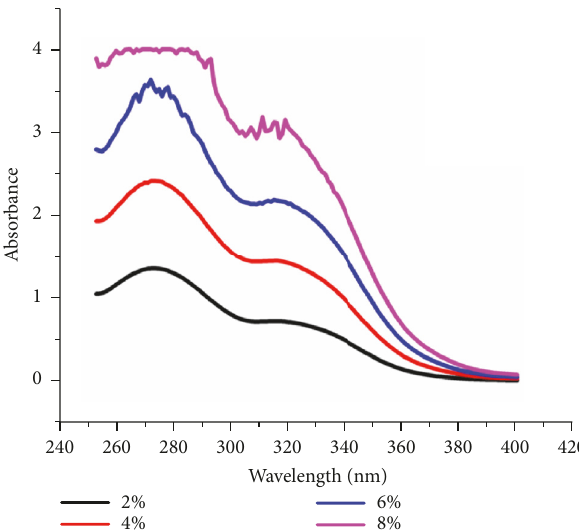
Figure 9: The streptomycin absorbance at wavelength of 250-400 nm.